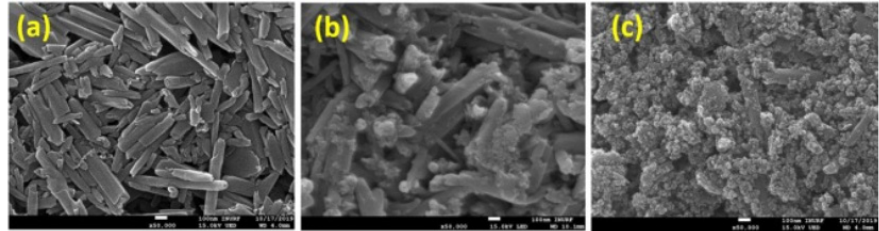
Figure 7. SEM images of ( a ) HNT s, ( b ) Fe 3 O 4 -HNTs and ( c ) Fe 3 O 4 -HNTs-Pd [95].